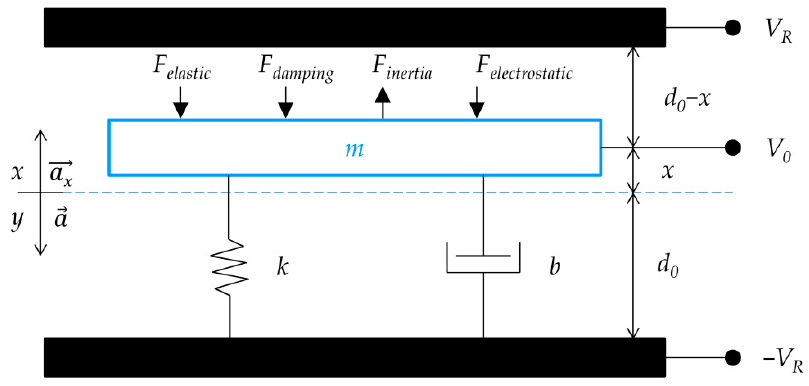
Figure 1. Capacitive accelerometer operational schema.